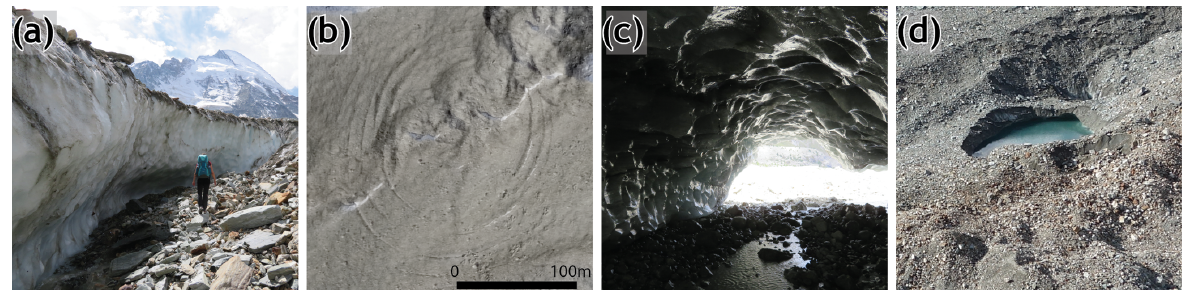
Figure 14. Examples of superficial and englacial ablation and their consequences. (a) Meander of a large supraglacial water channel with confining, under-cut ice cliff. (b) Almost circular surface lowering as a consequence of en- and subglacial ablation. (c) Subglacial water flow channel. (d) Supraglacial pond and ambient